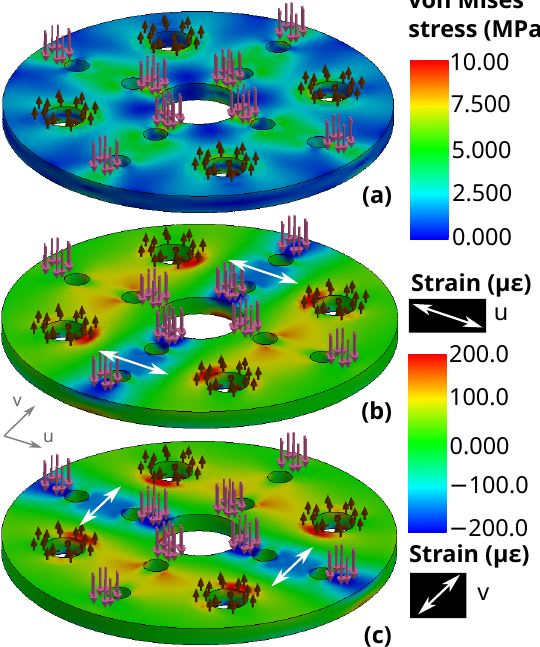
Figure 10. FEA simulation of a vertical 10.0N downwards force distributed around the strain gauges on the 3-DOF sensor. Applied forces are represented by pink arrows pointed down, while sup- port fixtures are represented by brown arrows. Surface coordinates u and vs. are represented by a grey frame. All results are viewed from top surface. Results include ( a ) von Mises stress field, ( b ) u-direction strain, and ( c ) v-direction strain fields. The axis being referenced for strain measure- ment is indicated by a white bidirectional arrow on the surface of the sensor at the gauge locations. The two strain axes are perpendicular, but are offset from established X-Y axes by 45